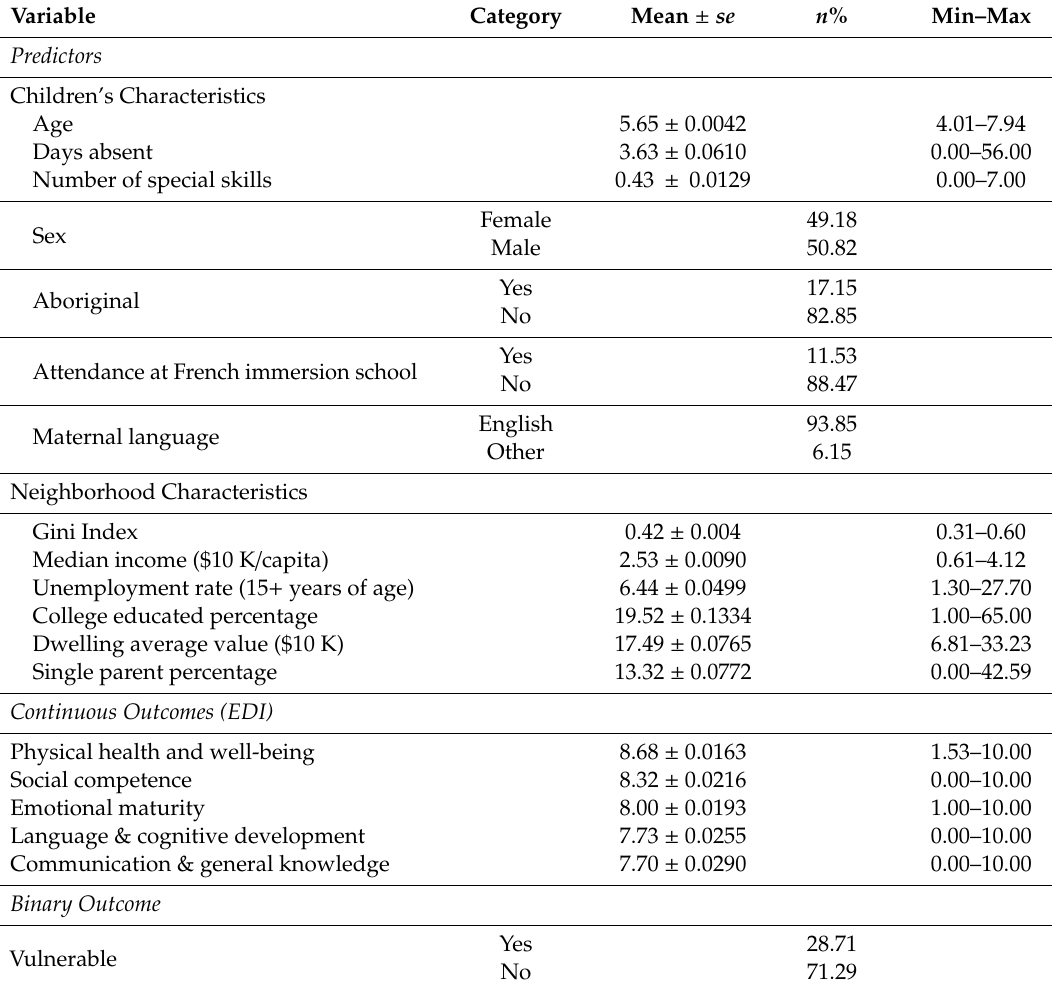
Table 1. Descriptive statistics of study variables ( n =